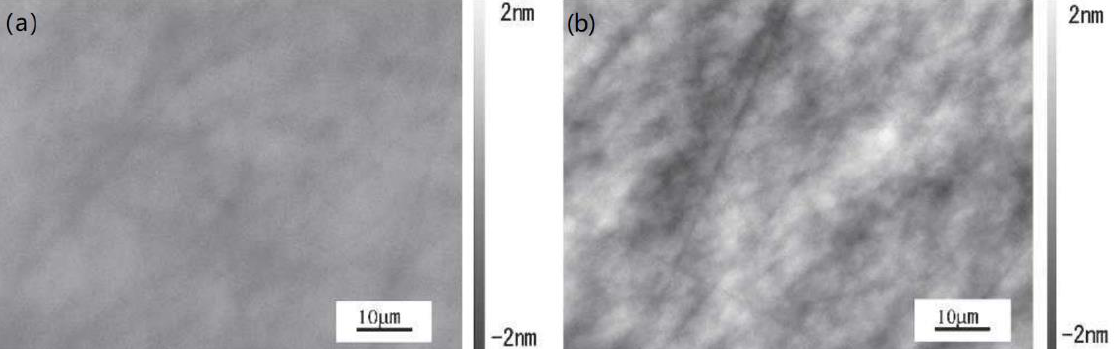
Figure 27. Optical interferometer images of a 4H-SiC wafer: ( a ) CARE-processed surface Ra: 0.114 nm, ( b ) as-received (after CMP) surface Ra: 0.436 nm [17].